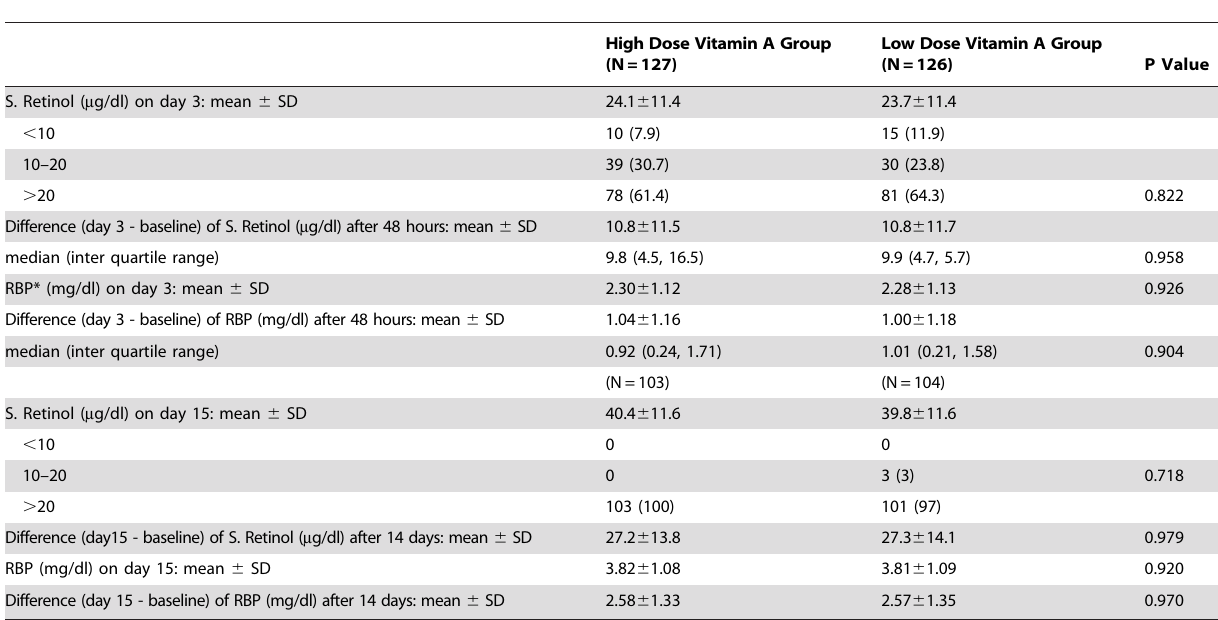
Table 3. Changes of serum retinol and retinol binding protein (RBP) over time by treatment group.